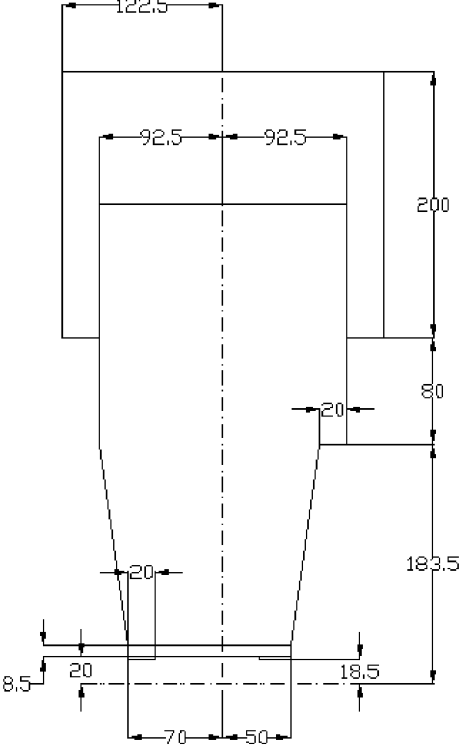
FIG. 15. Drawing in the x - y plane of a pole of the wiggler with also the optimized shims. Dimensions are in mm.